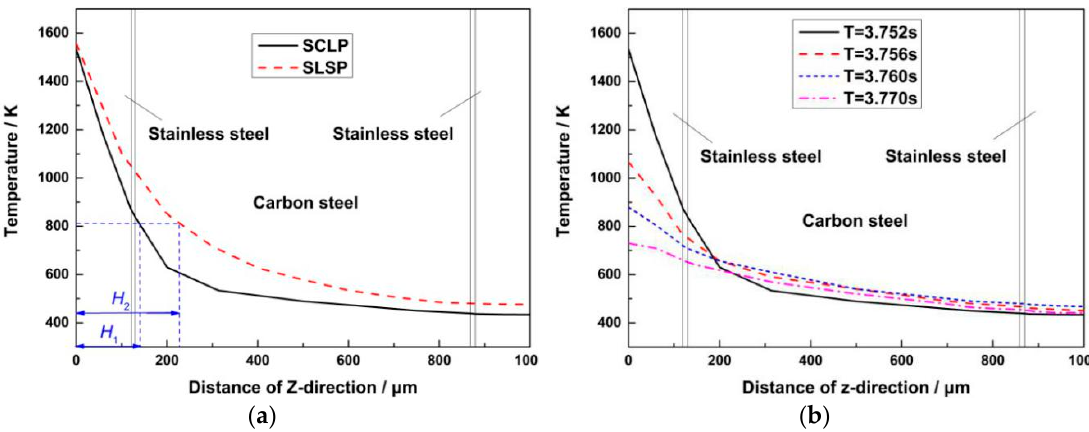
Figure 7. Temperature curve: ( a ) Comparison between the SCLP and the SLSP; ( b ) temperature curves of the SCLP at different moments.